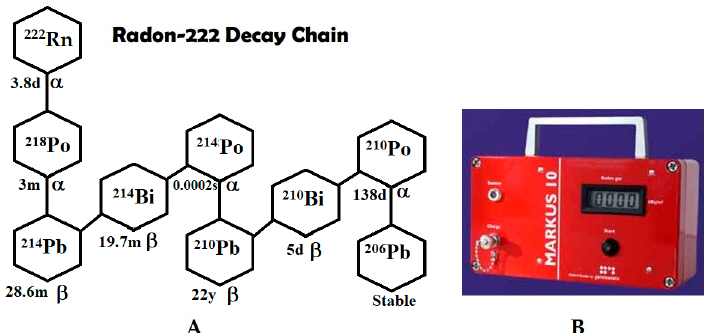
Figure 1. ( A ) Radon decay chain. Gaseous 222 Rn decays with a half-life of 3.8 d into 218 Po, which decays by alpha emission in three minutes [17]. ( B ) Gammadata’s Markus 10 instrument used to measure the radon concentration in